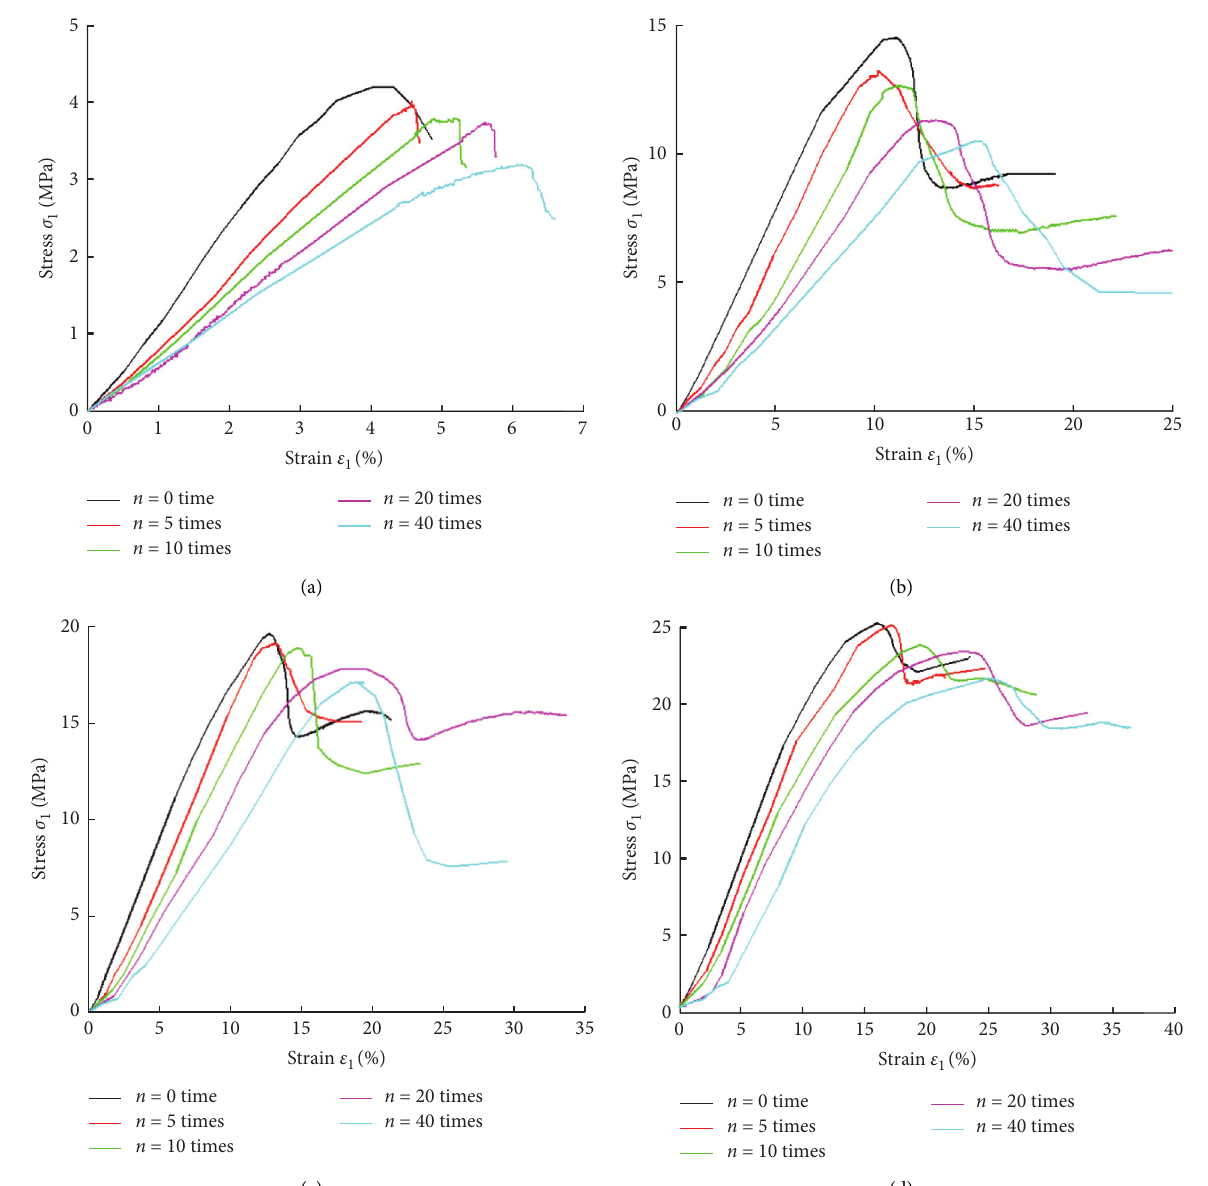
Figure 2: Full stress–strain curves of red sandstone triaxial compression test under different freeze-thaw cycles. (a) σ Table 1: Deterioration degree of red sandstone mechanical parameters under different freeze-thaw cycles. Confining pressure Freeze-thaw cycles times